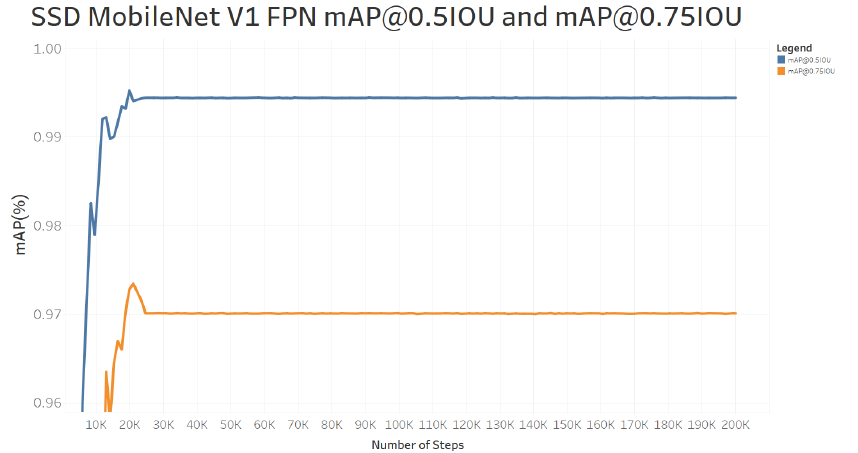
Figure 11. The SSDV1lite model settles a little under 99.5% at 0.5 IoU and 97% at 0.75